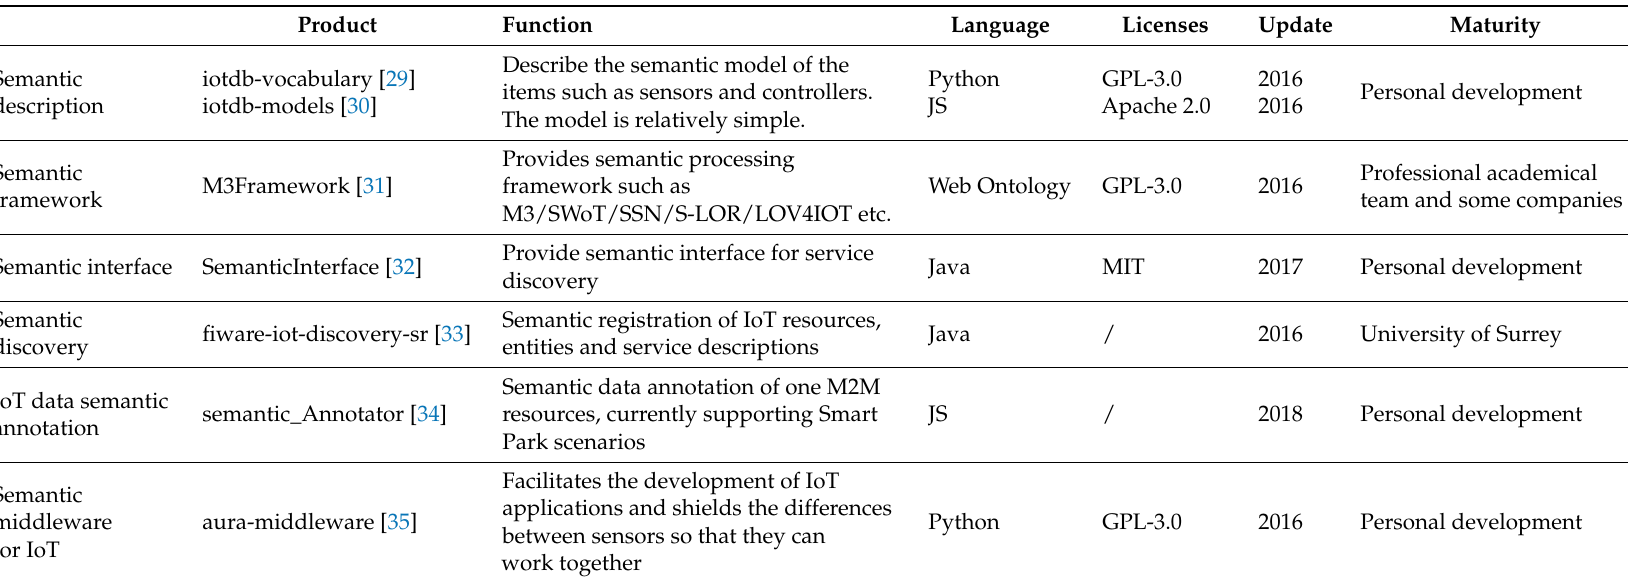
Table 1. Open source system comparison of semantic data